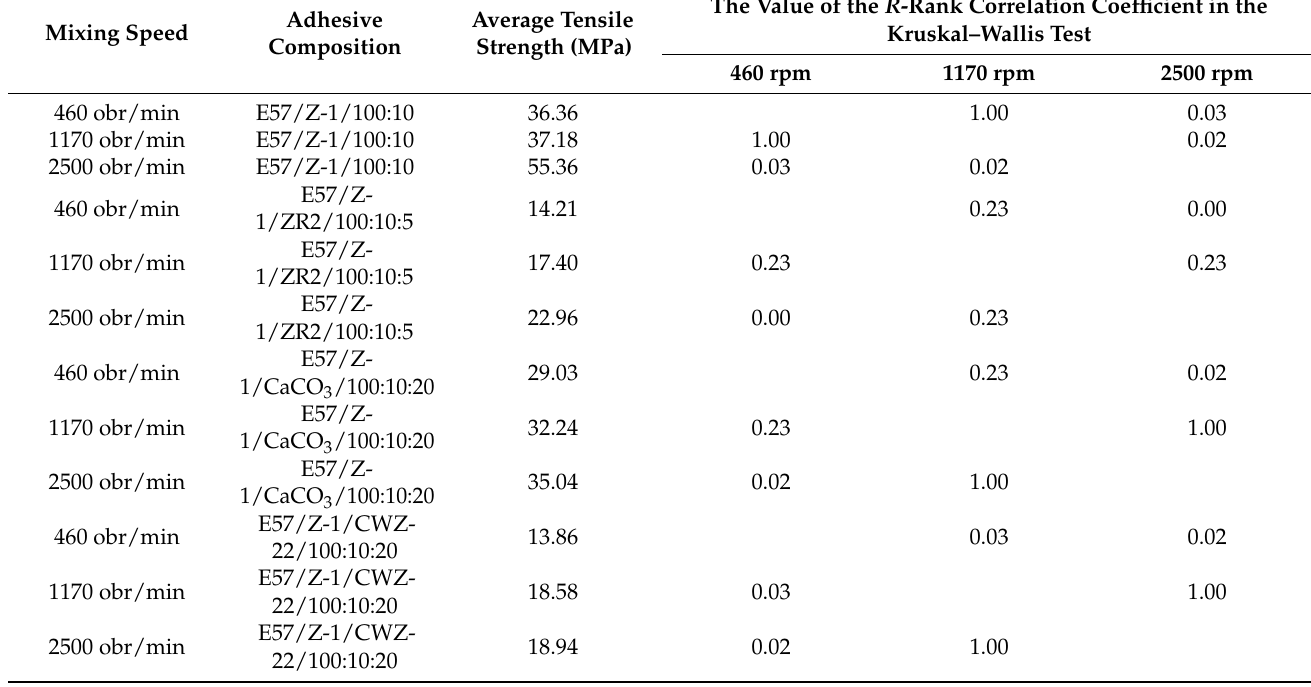
Table 7. Results of the Kruskal–Wallis test of multiple comparisons of average values of tensile strength of adhesive compositions grouped in relation to mixing